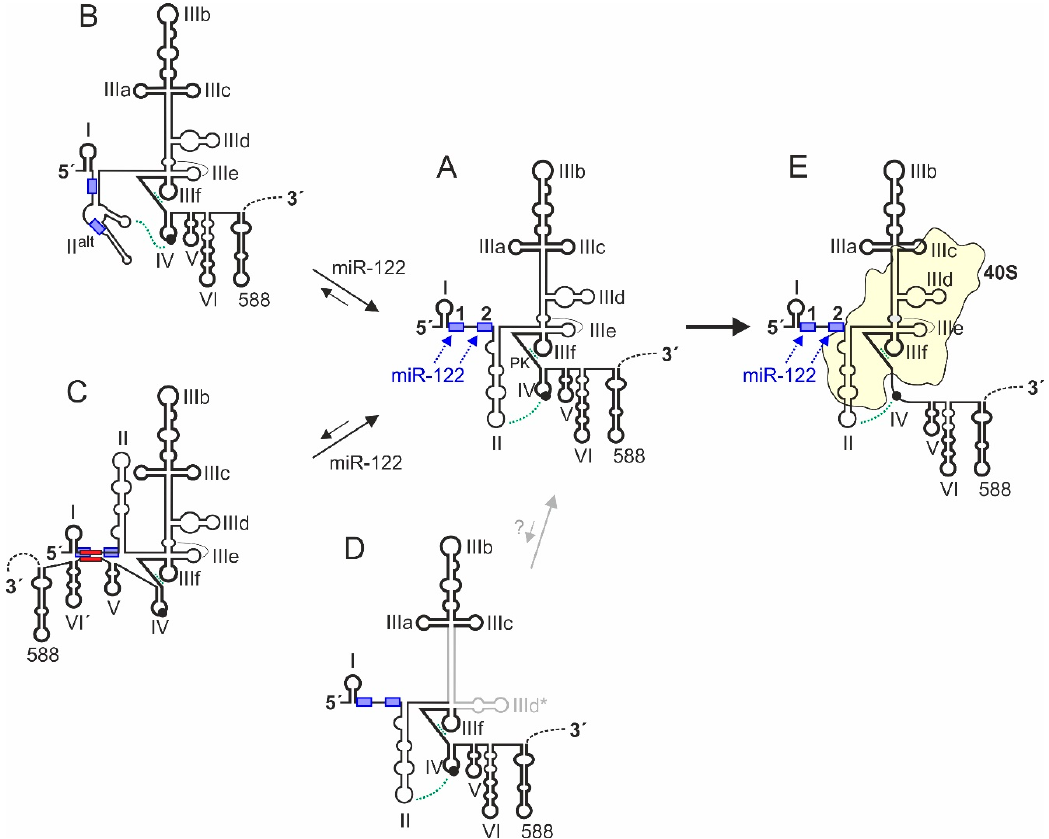
Figure 3. Conformational dynamics of HCV 5´UTR structure. The conserved canonical 5´UTR structure [63,109–114] is shown in the middle (structure A). 5´UTR sequences which have a strong intrinsic tendency to fold into a distinct secondary and tertiary structure are depicted in bold. The constitutive double pseudoknot (PK) interactions involving SL IIIe (PK2) and IIIf (PK1) and the possible interaction between SL II and SL IV are indicated. The 5´UTR structure B [72,77,115] has the region between SLs I and III refolded and forms an alternative version of SL II (SL II alt ). This SL II alt can form in the absence of miR-122, then hiding both miR-122 binding sites. Binding of miR-122 promotes refolding of structure B to structure A [72,115,122]. The 5´UTR structure C can form by fold-back of nucleotides 428–442 in the base of SL VI in the core protein coding region to hybridize with sequences downstream of SL I. In this state, the translation activity of the IRES is decreased [130–134]. This hybridization also interferes with binding of miR-122 to the 5´UTR. In turn, binding of miR-122 induces refolding of structure C to structure A [135]. Structure D is a yet completely hypothetic structure that was predicted to be the energetically slightly favored conserved structure [63]. In this structure D, the SL IIId of the IRES is refolded to form SL IIId*. However, a possible biological relevance of this hypothetical structure is unclear, in particular since several interactions of the canonical SL IIId have been described (see main text). Structure E is formed upon binding to the ribosomal 40S subunit. Then, SL IV sequences containing the AUG start codon are unfolded and positioned in the mRNA entry channel of the 40S subunit, aided by interaction with SL II. In contrast, other sequences are more flexible. This is particularly true for the region between SLs I and III. In the canonical 5´UTR structure (Figure 3A), the region between SLs I and II with the two miR-122 binding sites is predicted to be single stranded in RNAalifold structure predictions, and